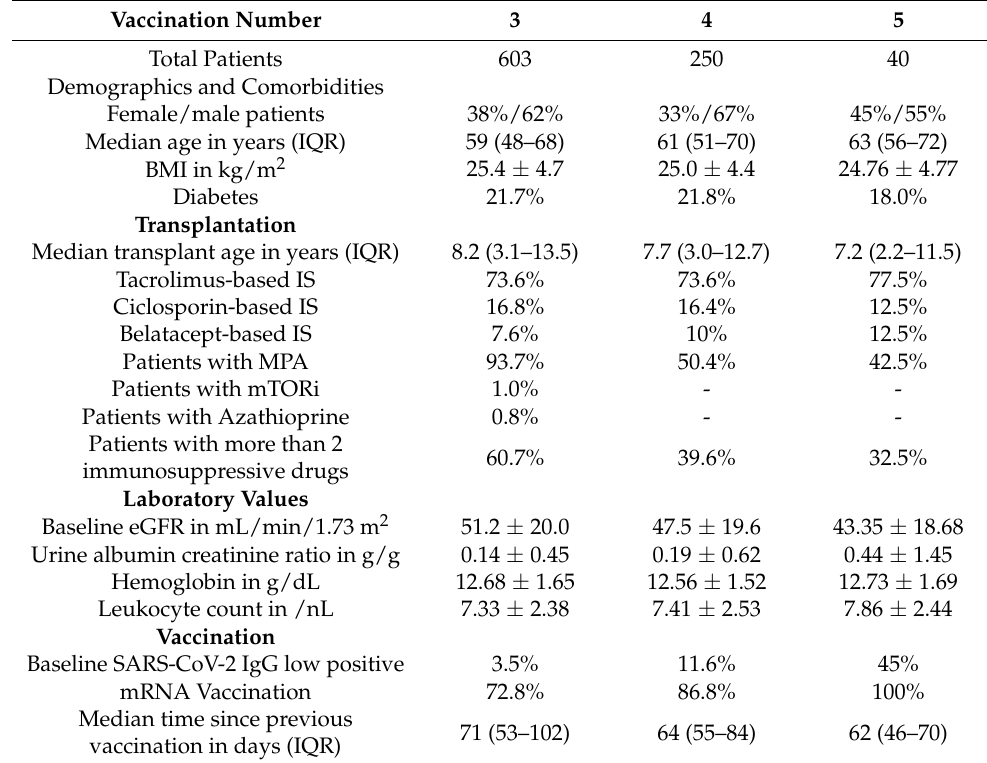
Table 2. Baseline characteristics of patients who received three, four, and five doses of SARS-CoV-2 vaccines. Continuous variables are presented as mean ( ± standard deviation) unless stated